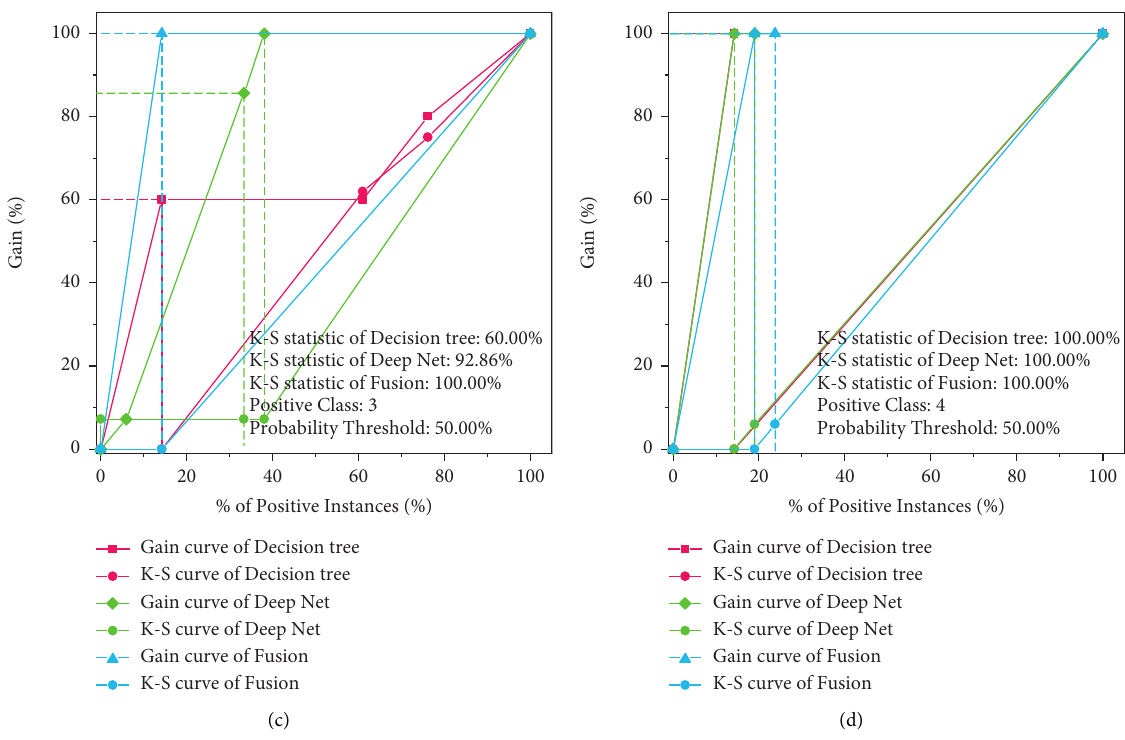
Figure 20: K-S curve and gain curve of each classification test of the fusion